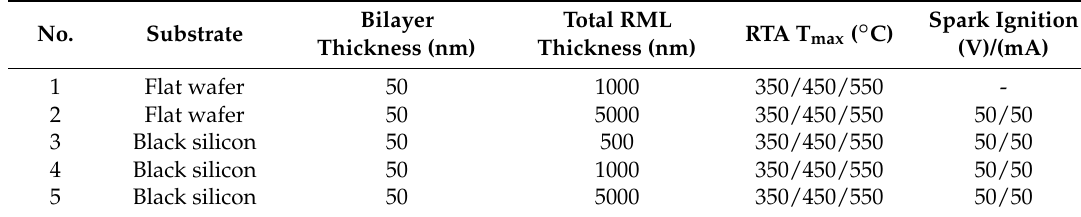
Table 1. Overview on samples and experimental design.